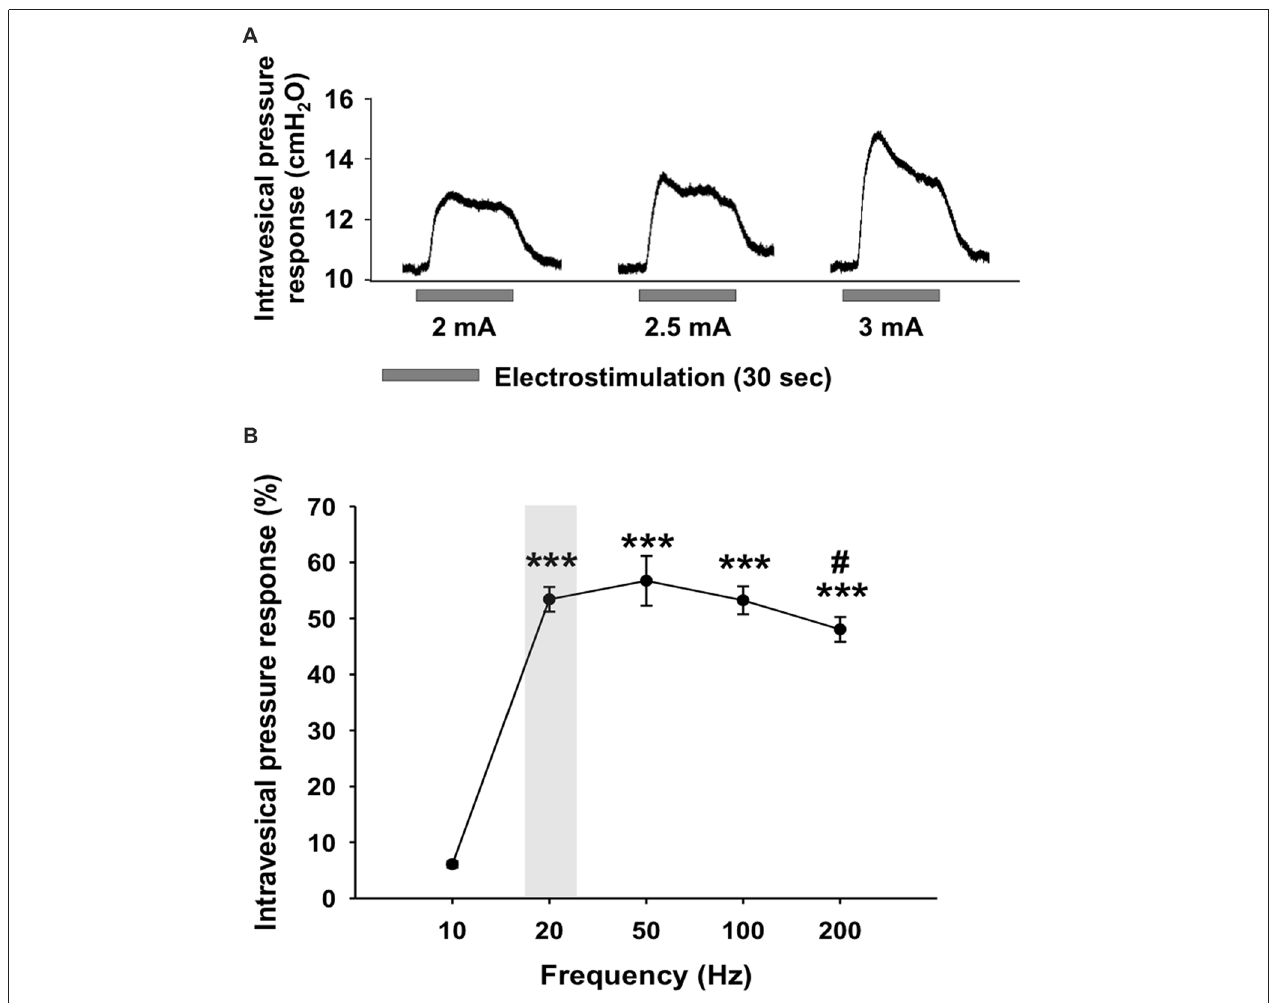
FIGURE 1 | Intravesical pressure responses during electrical stimulation of the urinary bladder. (A) Representative intravesical pressure responses during electrical stimulation with a frequency adjusted to 20 Hz and an intensity set at 2, 2.5 and 3 mA. (B) Intravesical pressure responses during electrical stimulation with intensity of 2 mA and variable frequency from 10 Hz and 200 Hz. The intravesical pressure responses were significantly lower for 10 Hz frequency compared to frequencies higher than 20 Hz. The increase in intravesical pressure following a stimulation with 200 Hz was lower than with 50 Hz. Values are represented as means ± SEM n = 5. One-way ANOVA, F ( 4,24 ) = 61.175, ∗∗∗ vs. 10 Hz, p < 0.001; # vs. 50 Hz, p =